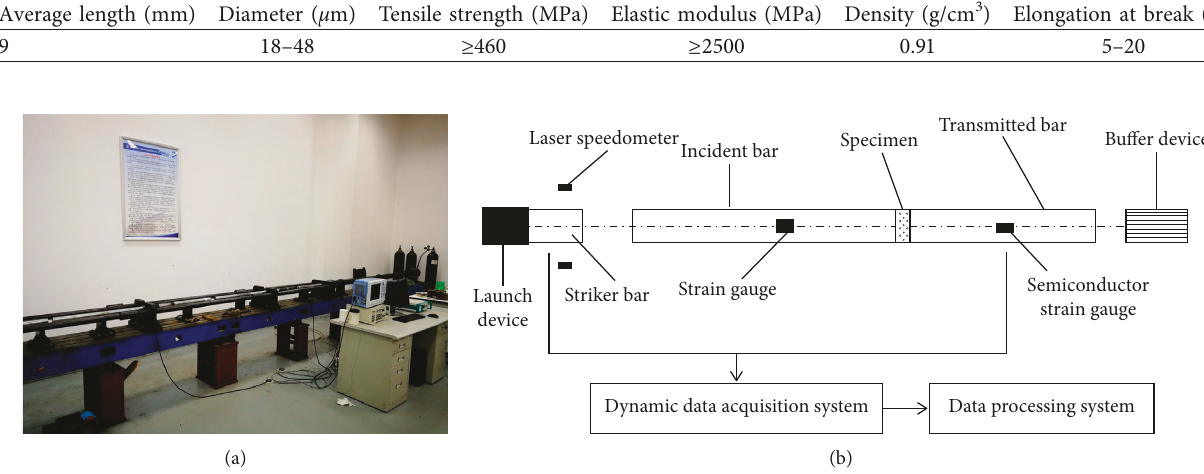
Figure 1: The split Hopkinson pressure bar (SHPB) device and its schematic diagram: (a) SHPB device; (b) schematic diagram.